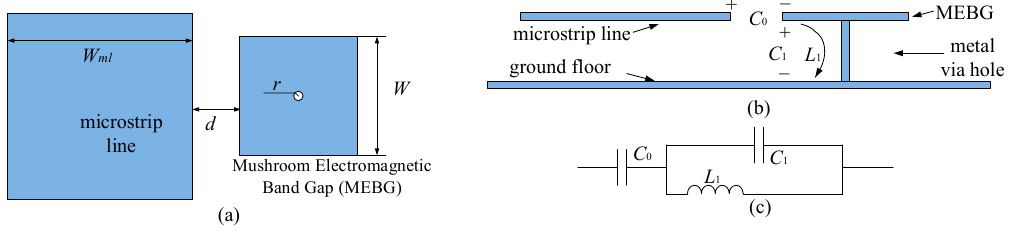
Figure 1. ( a ) The top view of the MEBG structure; ( b ) the side view of the MEBG structure; ( c ) the equivalent circuit diagram of the MEBG structure.